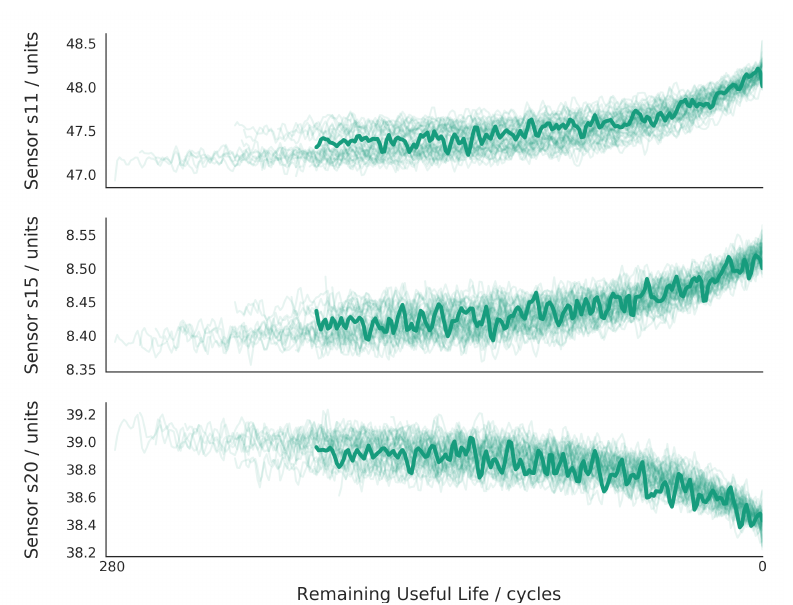
Figure 8. Readings of sensors 11, 15, and 20 during the engine complete lifetime training data of FD001. In the x-axis is denoted the RUL. For each sensor, several cycles of the dataset are overlaid. An example cycle is depicted in solid